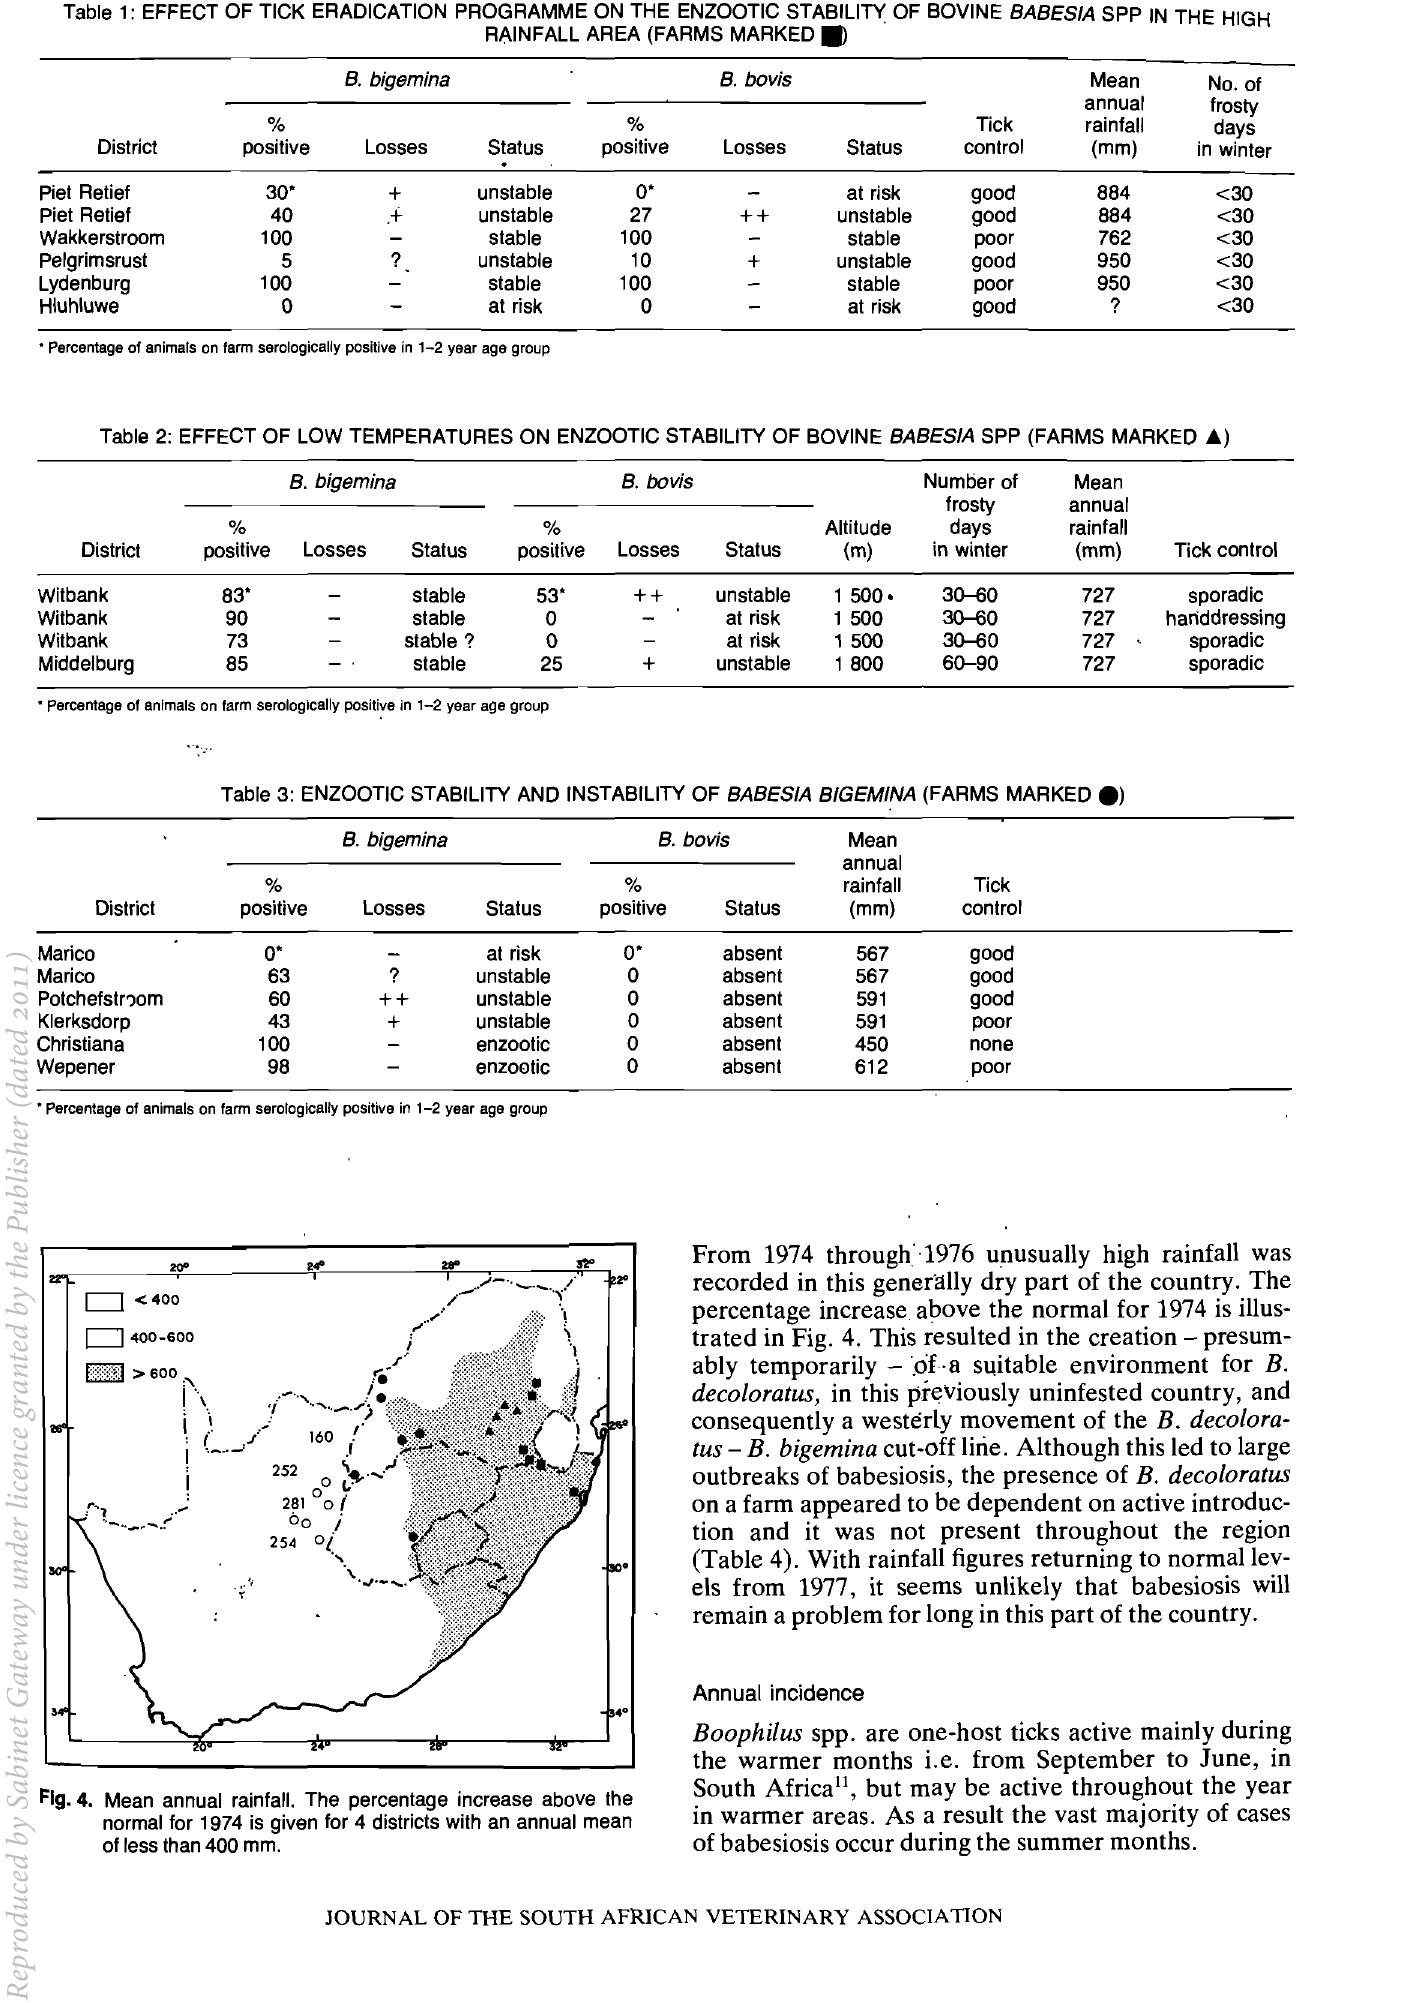
Fig. 4. Mean annual rainfall. The percentage increase above the normal for 1974 is given for 4 districts with an annual mean of less than 400